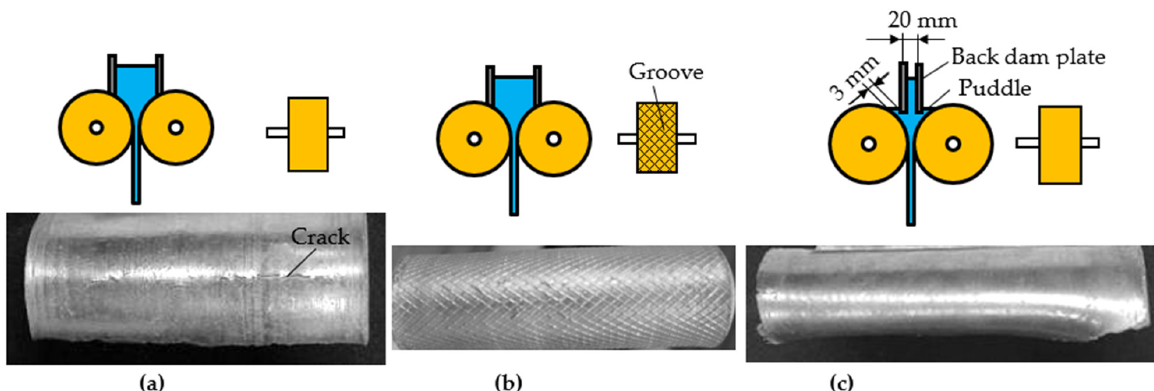
Figure 8. Outer surfaces of bent strips cast using three types of casting conditions. Aluminum alloy: 6022, Roll speed: 60 m/min, Roll load: 0.14 kN/mm, Roll diameter: 300 mm, Roll width: 50 mm, Solidification length: 100 mm ( a ) vertical-type high-speed twin-roll caster with a flat surface, ( b ) vertical-type high-speed twin-roll caster with a cross groove shown in Figure 6a, ( c ) vertical-type high-speed twin-roll caster with puddle with a flat surface roll.